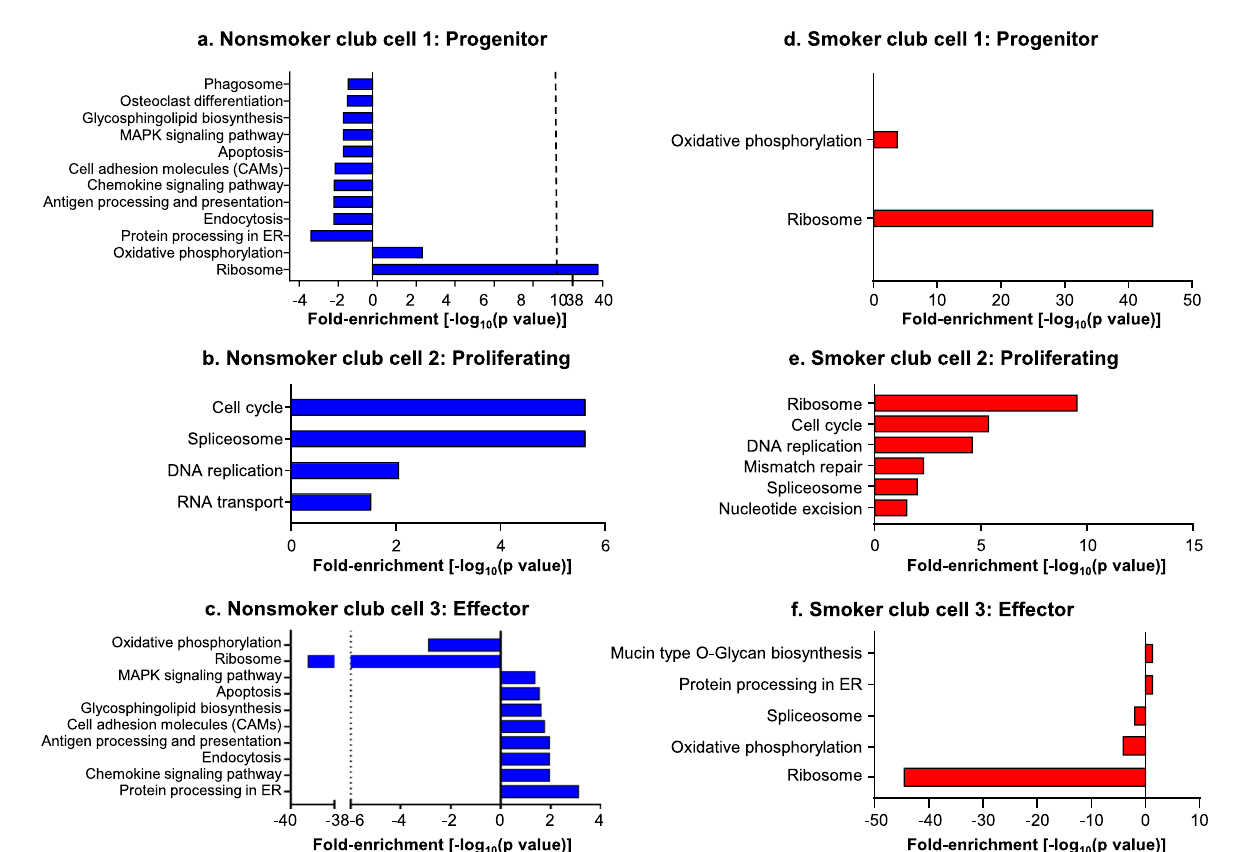
Fig. 5 Different functions of the club cell subpopulations predicted using GAGE analysis in nonsmoker and smoker club cell subclusters. Shown are the enriched pathways in the three club cell populations of nonsmokers ( a – c ) and smokers ( d – f ). The Benjamini – Hochberg corrected p value indicating the signi fi cance of the relative contributions from each pathway are graphed using the negative of the logarithm of the corrected p value. Club cell subsets 1 – 3 were named according to their enrichment pro fi le. a Nonsmoker progenitor club cells. b Nonsmoker proliferating club cells. c Nonsmoker effector club cells. d Smoker progenitor club cell. e Smoker proliferating club cells. f Smoker effector club cells. To enable a direct comparison of the effect of smoking on effector club cells, the GAGE analyses for nonsmoker and smoker effector club cells have been plotted together in Supplementary Fig.